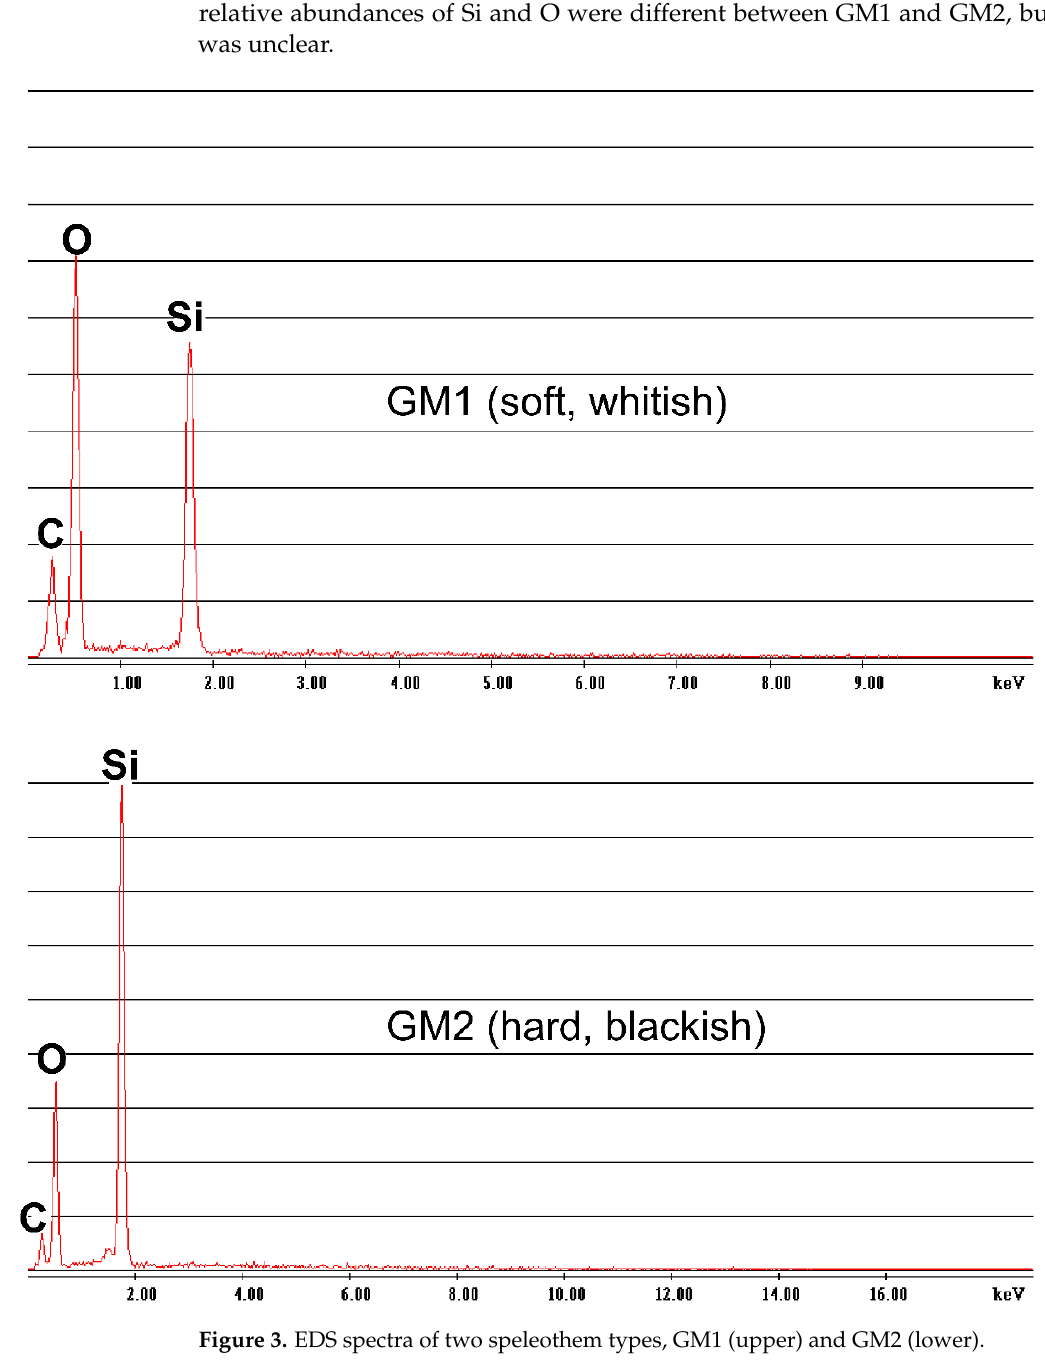
Figure 3. EDS spectra of two speleothem types, GM1 (upper) and GM2 (lower). The sharp peaks in the PXRD patterns (Figure 4) corresponded to those of quartz according to Powder Diffraction File 00-046-1045 (quartz) of International Center for Dif- fraction Data (https://www.icdd.com). The difference in the quartz peak intensity between the two samples was due to a greater or lesser inclusion of quartz grains. The lump with a maximum at 22 degrees was the most important feature; it is typical of opal-A [37] and was observed in Venezuelan tepui cave speleothems [27] (p. 84, Figure 79A).